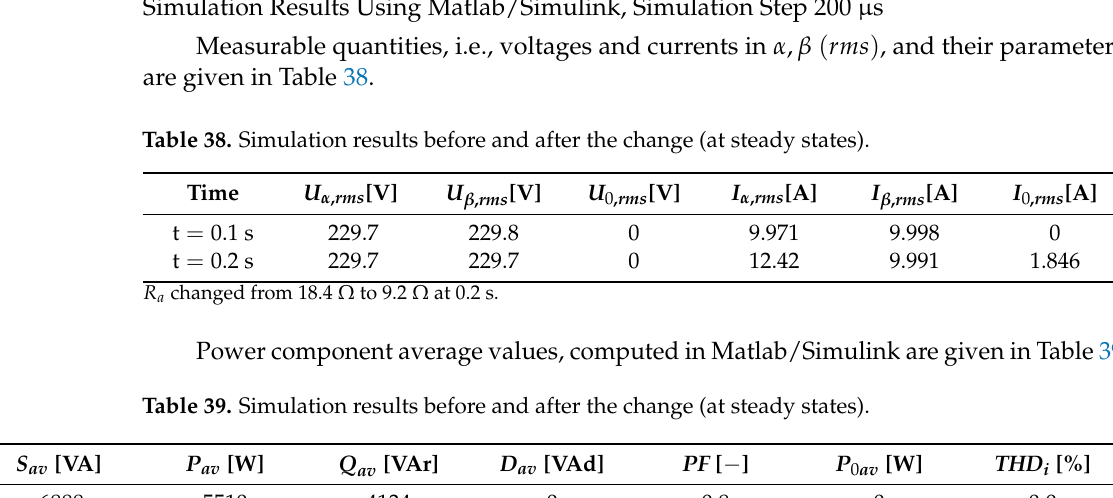
Table 37. Load parameters for steady states before and after load change.